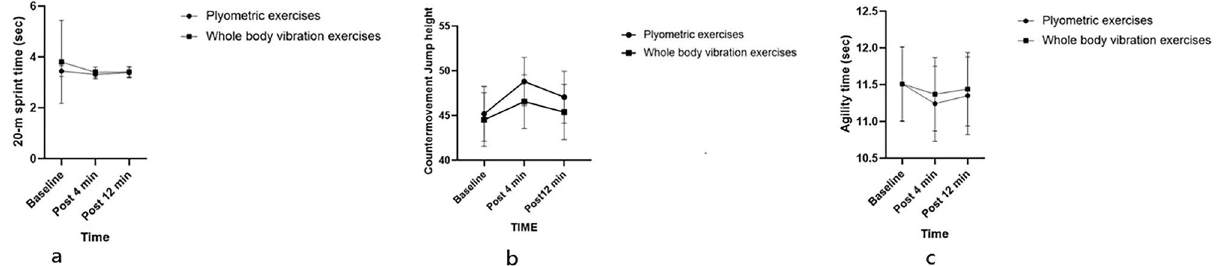
Figure 3. ( a ) Maximal height in the Counter movement Jump performance for plyometrics and whole-body vibration group at specified intervals; ( b ) Maximal 20-m sprint time for the plyometric and whole-body vibration group at specified time intervals; ( c ) Maximal agility time for the plyometric and whole-body vibration group at specified time intervals